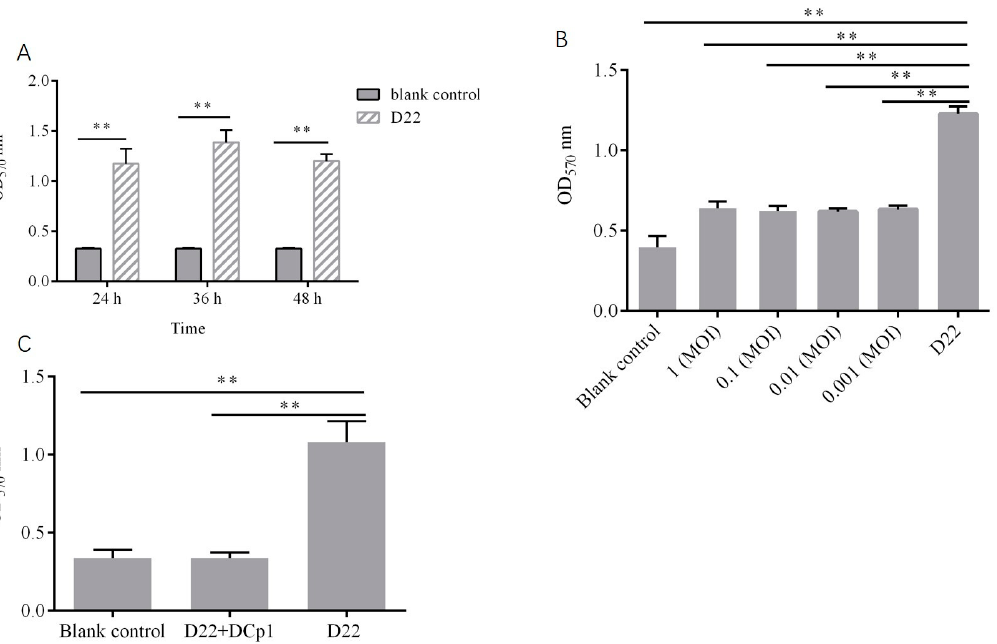
Figure 8. Effects of phage DCp1 on the biofilm of C. perfringens D22. **: p < 0.01 ( A ) Biofilm formation of C. perfringens D22 after different periods of incubation. ( B ) Inhibitory effect of phage DCp1 on the biofilm at different MOIs. ( C ) Eradicative effect of phage DCp1 on the biofilm. Phage DCp1 completely eradicated the biofilm after 5 h.